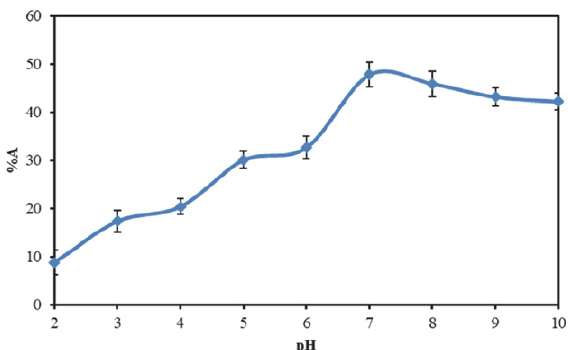
Figure 5. Effect of pH on the adsorption of metformin on the